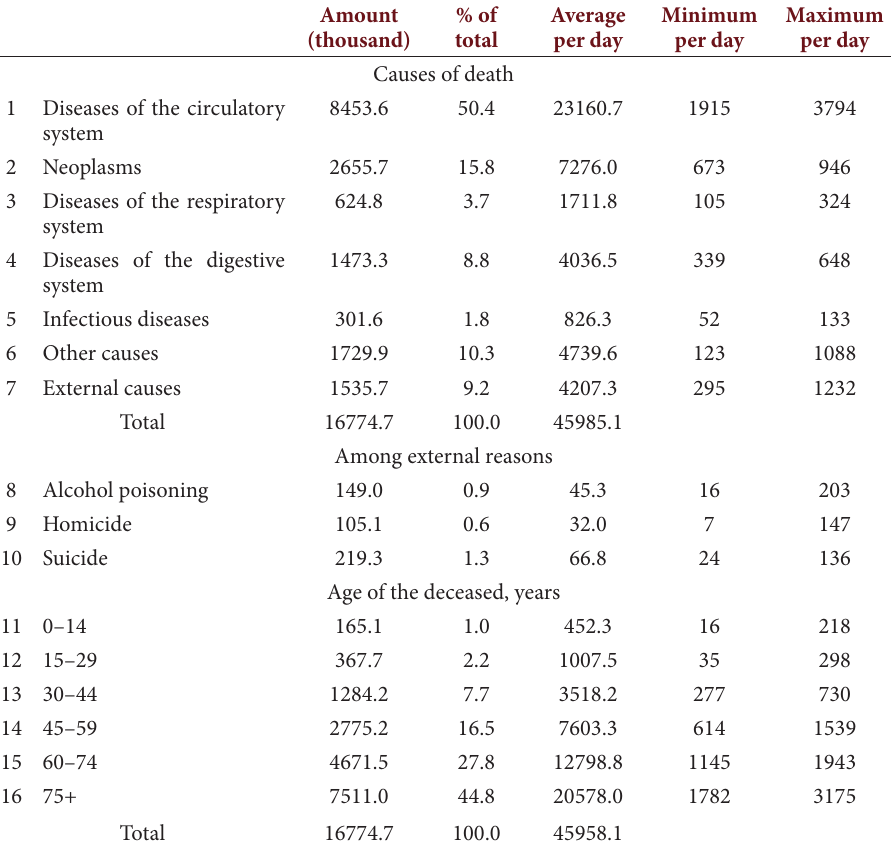
Table 1. Distribution of deaths by cause and age in